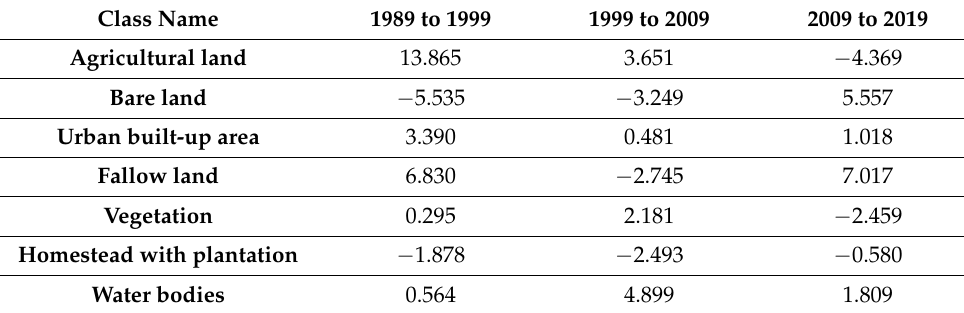
Table 9. Rate of changes (in percentage, %) in LULC areas over the